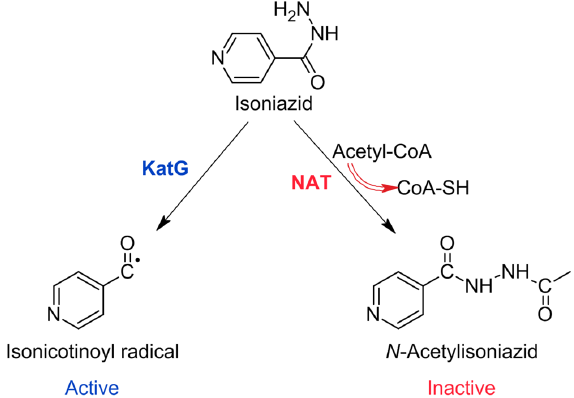
Figure 2. Activation and inactivation pathways of INH.